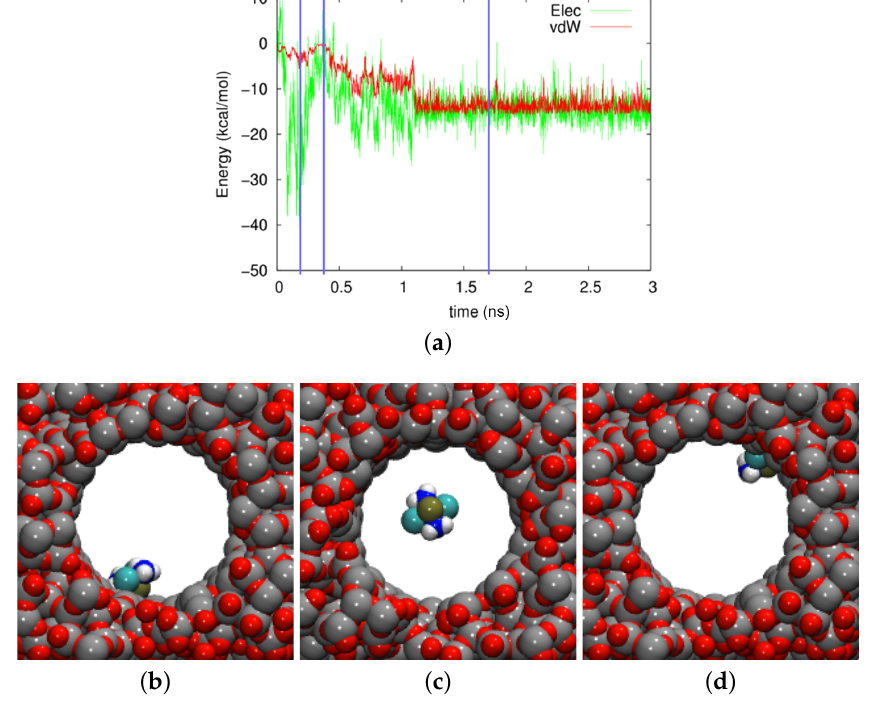
Figure 6. ( a ) Evolution of the electrostatic (Elec) and vdW energies between the cisplatin molecule and the amorphous silica pore during the diffusion process. ( b – d ) show snapshots at times of ( b ) 182 ps, ( c ) 388 ps, and ( d ) 1700 ps. These times are marked in ( a ) by vertical blue